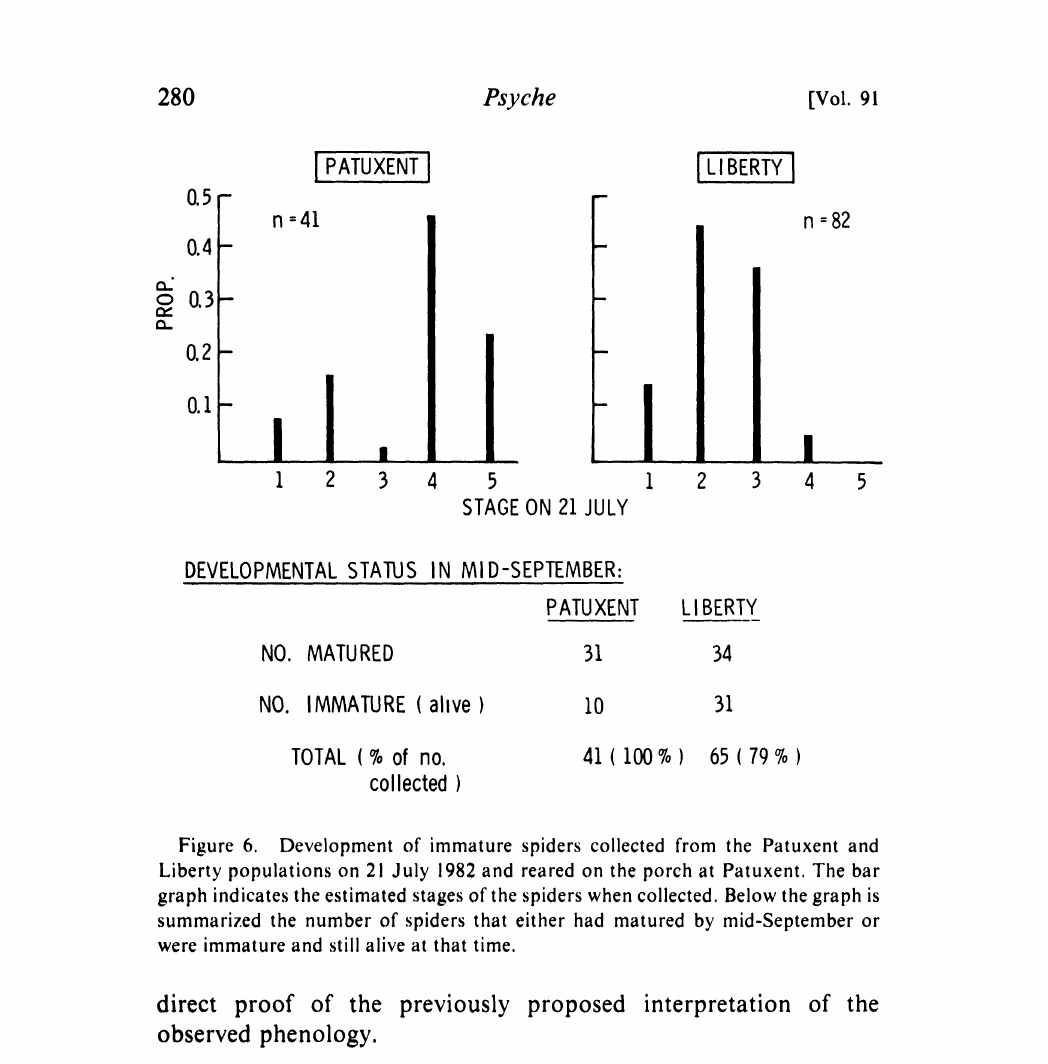
Figure 6. Development of immature spiders collected from the Patuxent and Liberty populations on 21 July 1982 and reared on the porch at Patuxent. The bar graph indicates the estimated stages of the spiders when collected. Below the graph is summarized the number of spiders that either had matured by mid-September or were immature and still alive at that